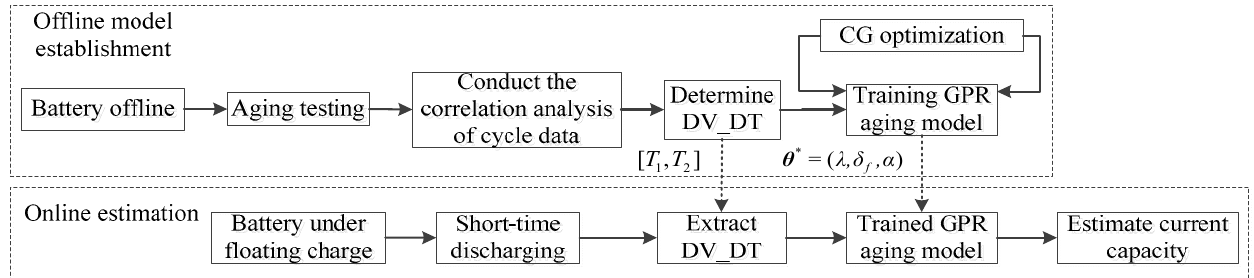
Figure 6. The flow chart of the proposed method.